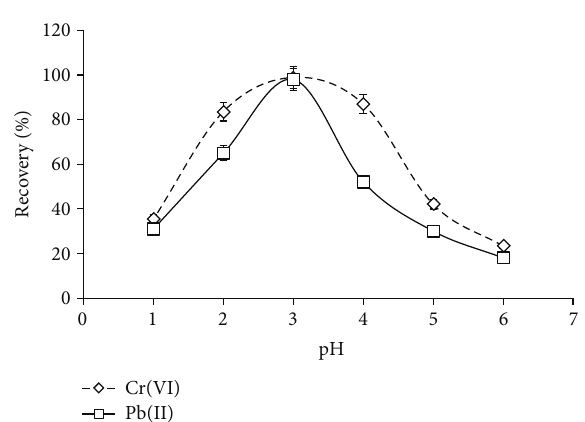
Figure 2: Influence of sample pH on DLLME at 40mL initial volume of water samples 0.25% APDC, 100 𝜇 L CCl 4 , 1.00mL of ethanol, and 0.01mg/L Cr(VI)/Pb(II).